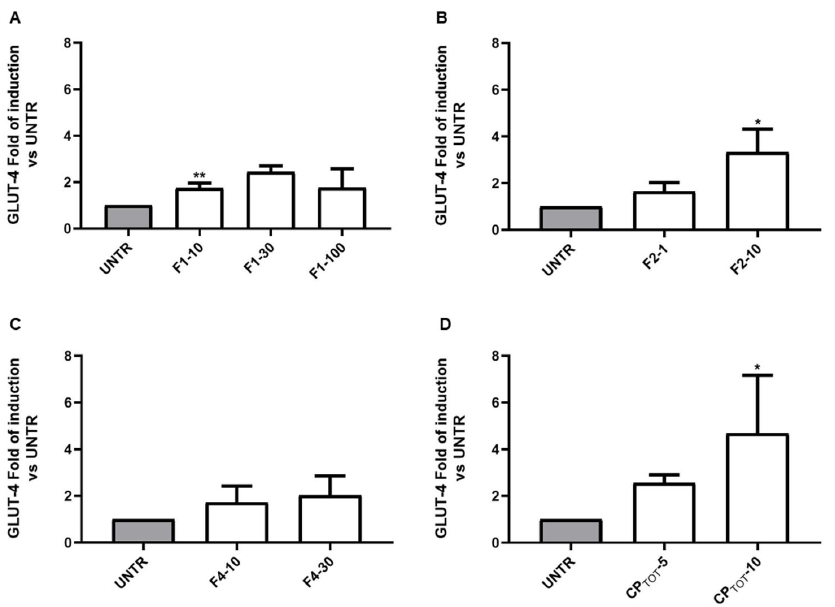
Figure 3. Effect of CP fractions and total extract on GLUT ‐ 4 mRNA level. GLUT ‐ 4 mRNA level was evaluated by RT ‐ PCR on the 3T3 ‐ L1 cell line at the end of the adipocyte differentiation time and after the contemporary treatment with the indicated concentration ( μ g/mL) of fractions 1 (F1, in ( A) ), 2 (F2, in ( B )), and 4 (F4 in ( C )) or of the total extract (CP TOT , in ( D )). Untreated cells (UNTR) did not receive any treatment. Results are reported as mean ± SEM of at least three independent experiments performed in duplicate. * p < 0.05, ** p <